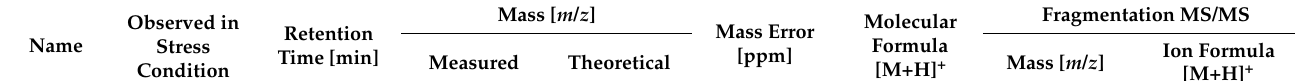
Table 1. Accurate mass elemental composition and proposed structures of the analyzed